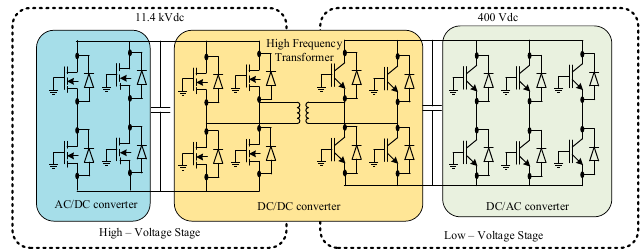
Figure 2. SST at one residential home.